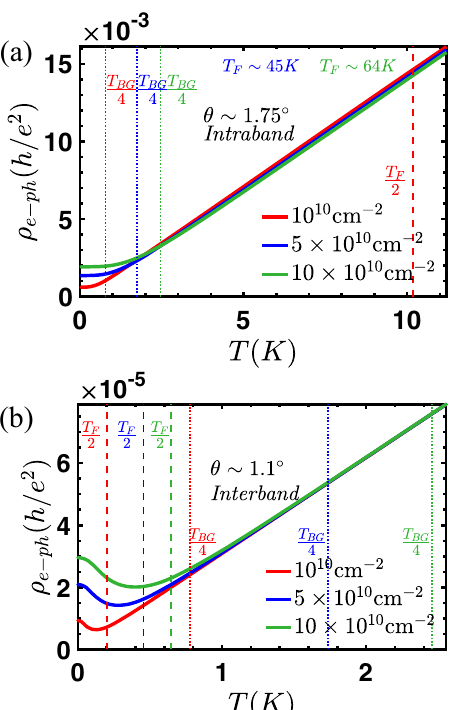
Fig. 3 The persistence of linear-T behaviour to low temperature is due to inter-band scattering. Electron – phonon resistivity for tBG within the Dirac model for a intraband scattering and b interband scattering. Dotted and dashed lines indicate T BG /4 and T F /2, respectively. Interband resistivity shows a transition to linear-in- T at ∼ T F /2 compared to intraband resistivity which shows a transition around ∼ T BG /4. In the interband regime, the striking persistence of linear-in- T behavior for T ≪ T BG is observed.